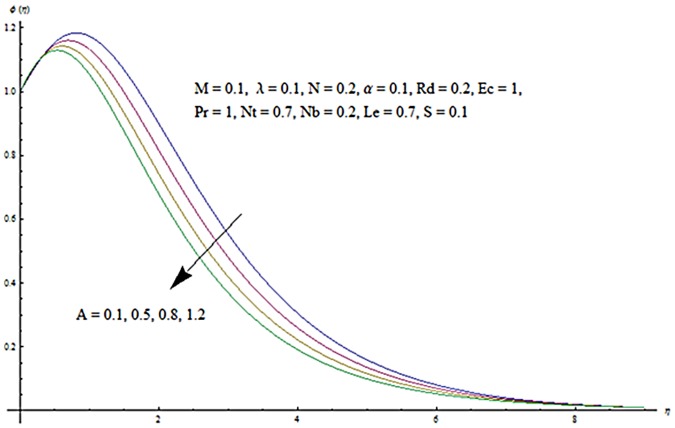
Influence of A on ϕ.